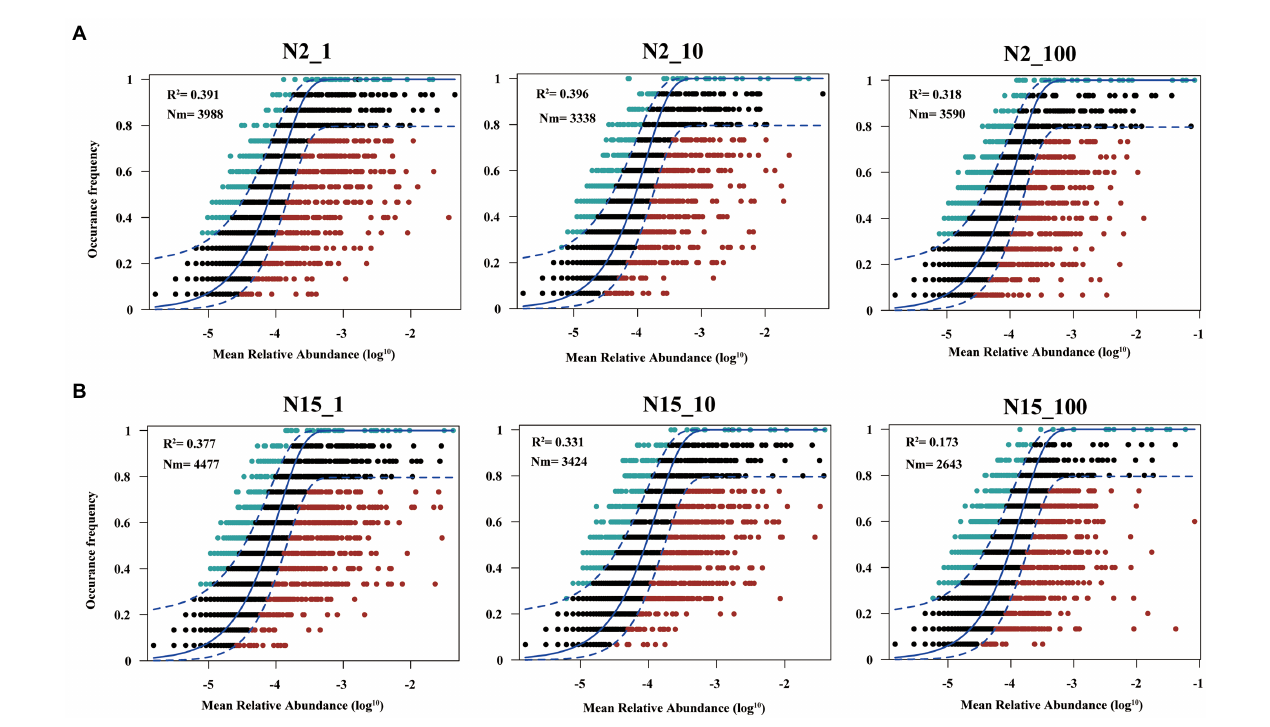
FIGURE 5 Fit of the neutral model to assess the effects of random dispersal and ecological drift on the assembly of bacteria communities. (A) Sample N2 with 1 μ g/l, 10 μ g/l and 100 μ g/l E1 (labeled as N2_1, N2_10 and N2_100, respectively); (B) Sample N15 with 1 μ g/l, 10 μ g/l and 100 μ g/l E1 (labeled as N15_1, N15_10, and N15_100, respectively). OTUs that occur more frequently than predicted by the model are shown in green while those that occur less frequently than predicted are shown in red. Dashed lines represent 95% confidence intervals around the model prediction (blue